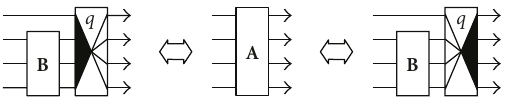
Figure 5: Structural transformation corresponding to